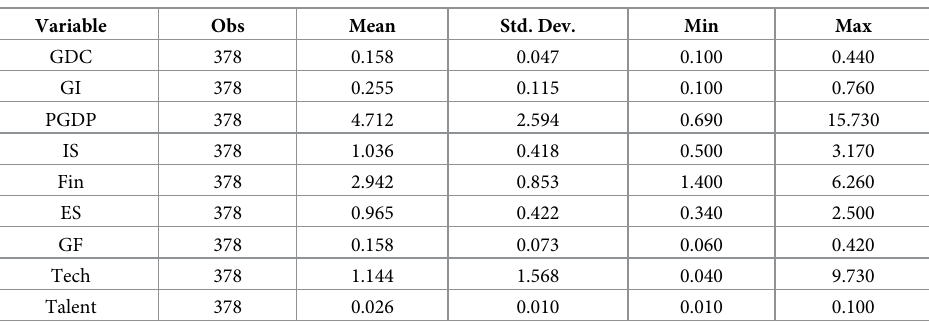
Table 3. Descriptive